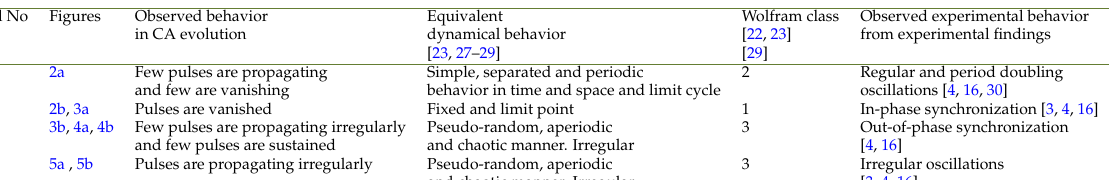
Fig. 2. Evolutionary pattern for pressure in coupled nephron tubule. Table 3. CA behavior analysis of coupled nephron model for compliance tubule in comparison with experimental findings Sl No Figures